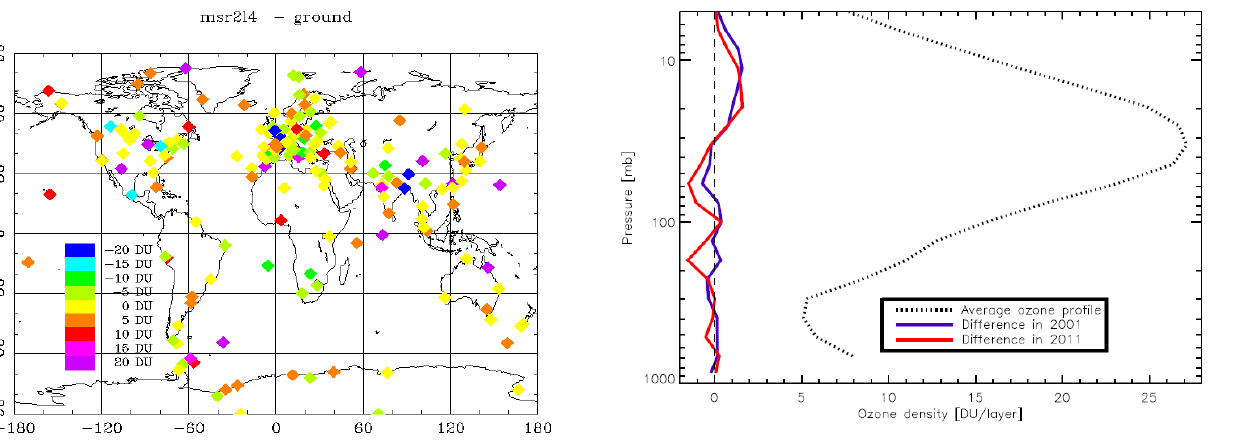
Figure 10. Validation of the ozone distribution in the model using a selection of about 30–40 ozone sonde stations. The mean differ- ence between the sonde and MSR2 ozone profile is shown for 2001 (blue) and 2011 (red). For reference the average ozone profile of the sondes is shown (dotted